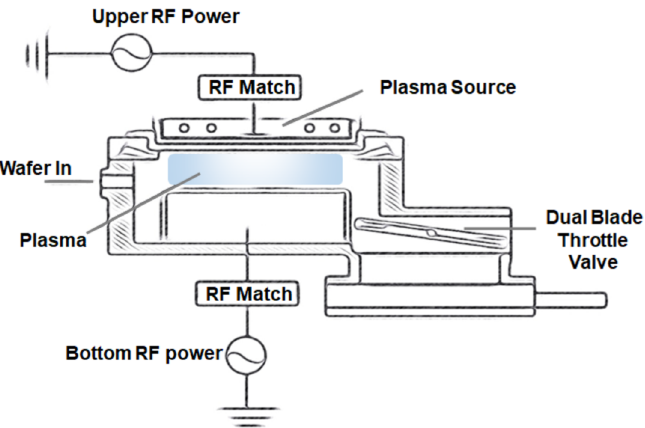
Figure 1. Schematic illustration of the planar HDP system used in this experiment.